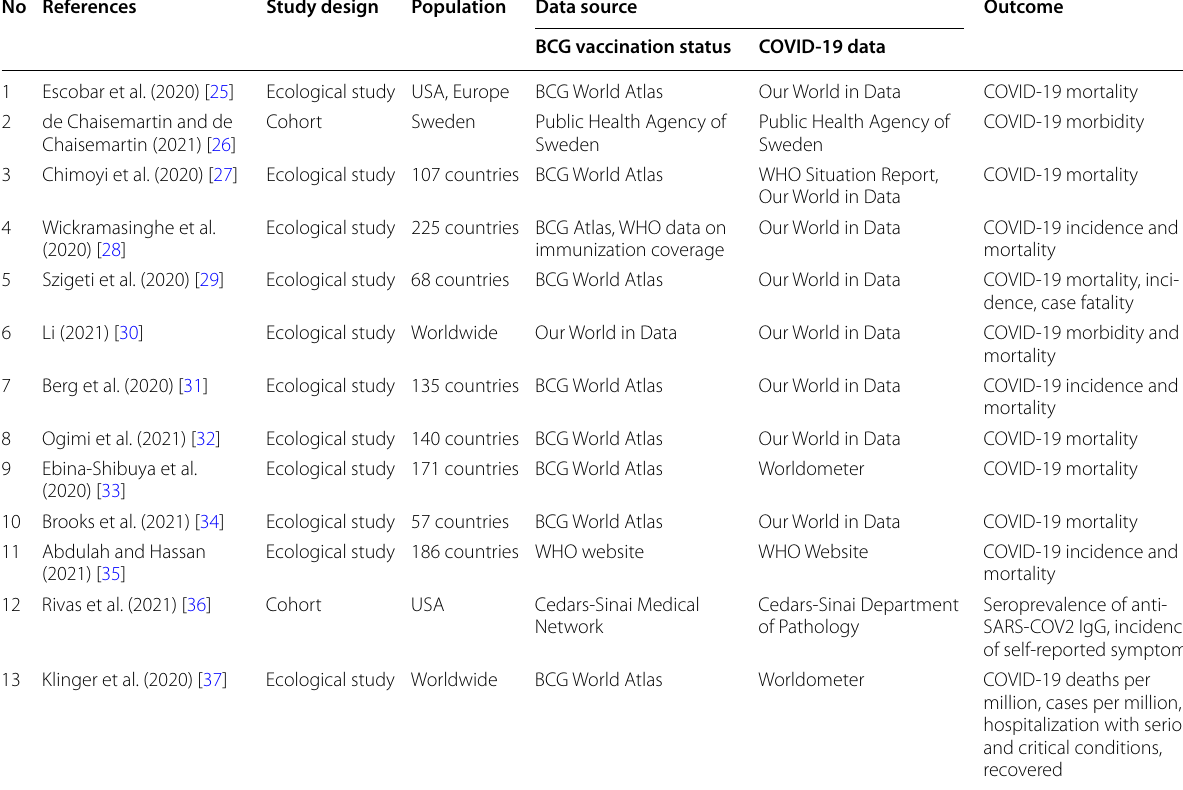
Table 2 Characteristics of reviewed studies